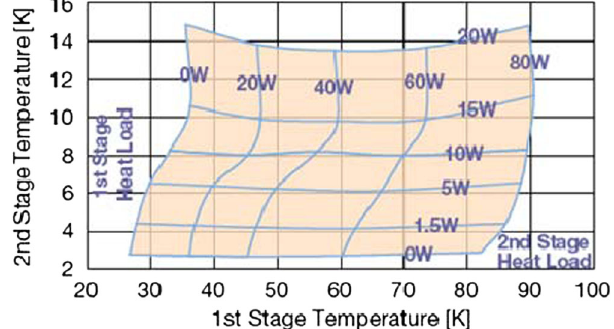
FIG. 13. Cooling power as a function of temperature for the first and second stages of a commercial cryocooler (SRDK-415D, Sumitomo Cryogenics of America) [32].